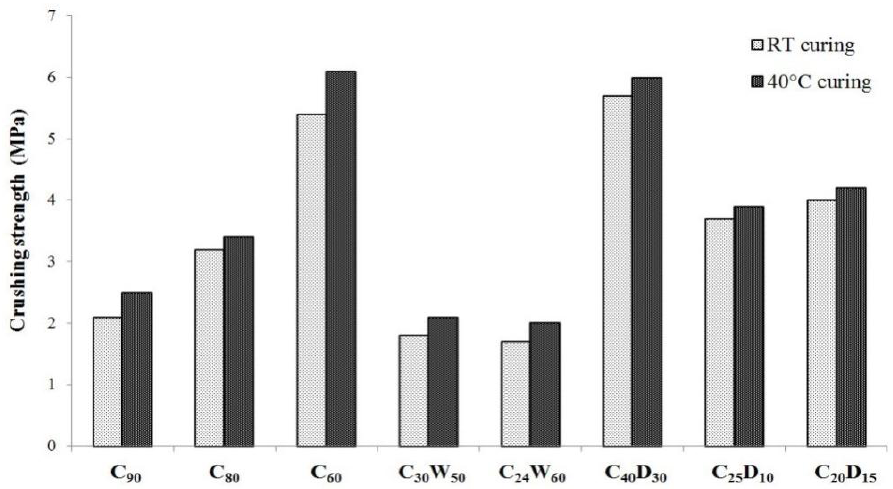
Figure 10. Crushing strength of artificial aggregates.